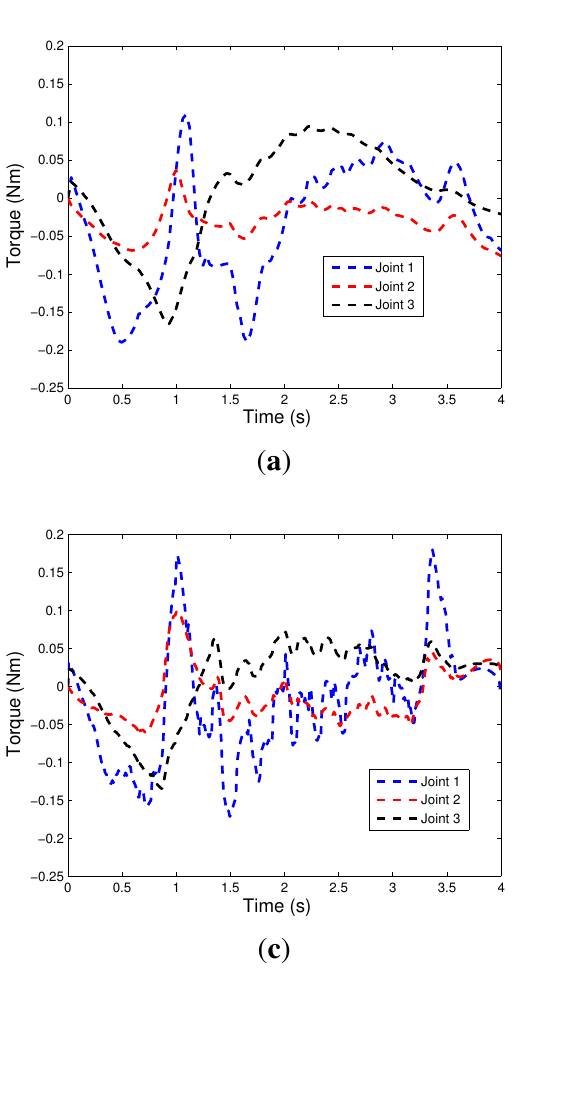
Figure 10. Joint Torque. ( a ) NN1; ( b ) NN2; ( c ) FS1; ( d ) FS2; ( e )